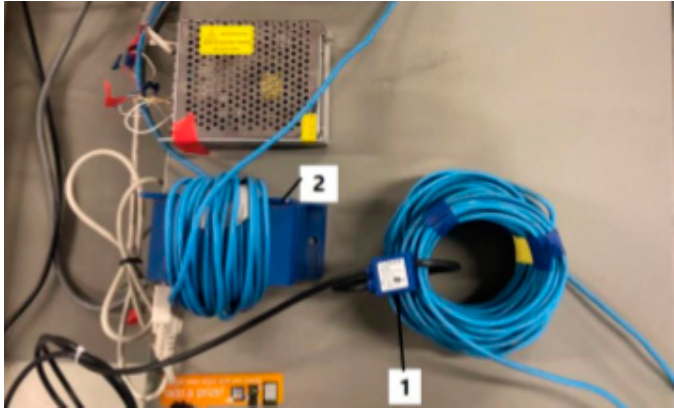
Figure 9. Sensor to be calibrated and standard sensor for the experiment.